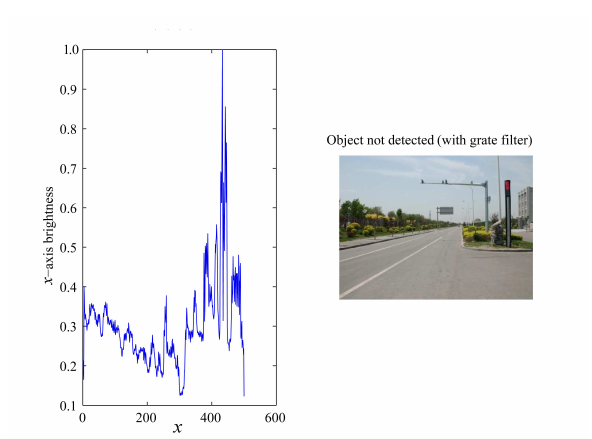
Fig. 27 Horizontal axis’ brightness values and search result (with grate filter) according to Fig.